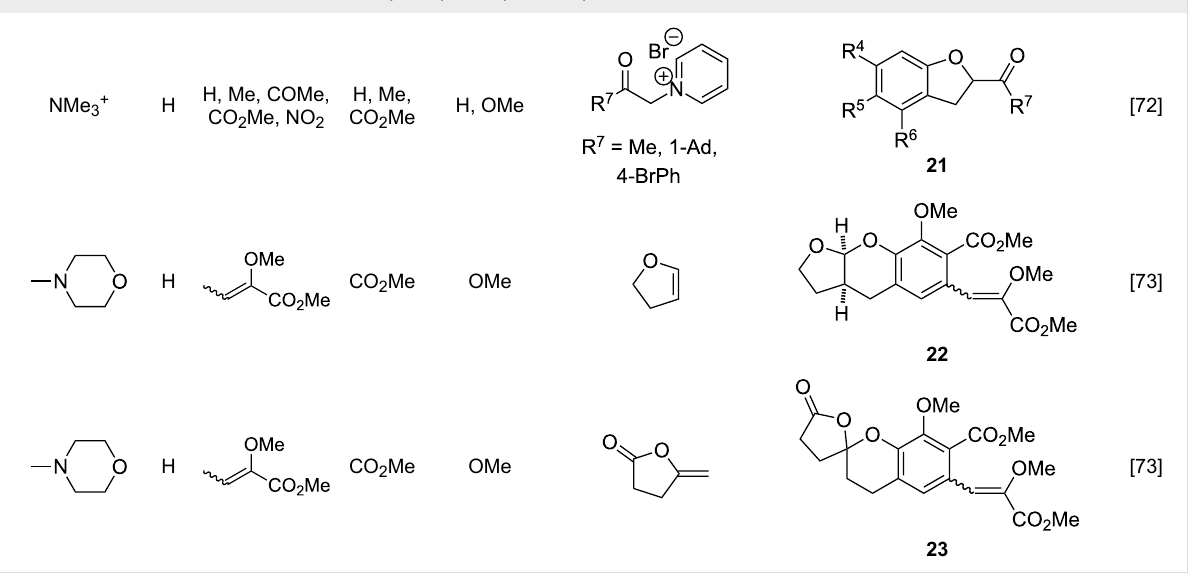
Table 3: Reactions of o -QMs with different dienophile species.